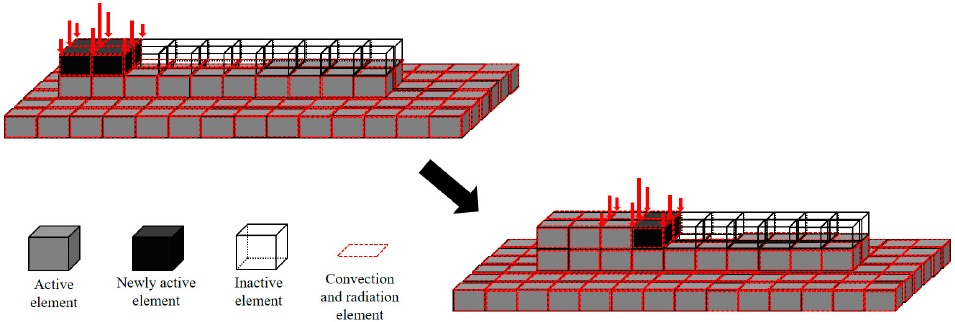
Figure 5. Schematic representation of the element birth technique.